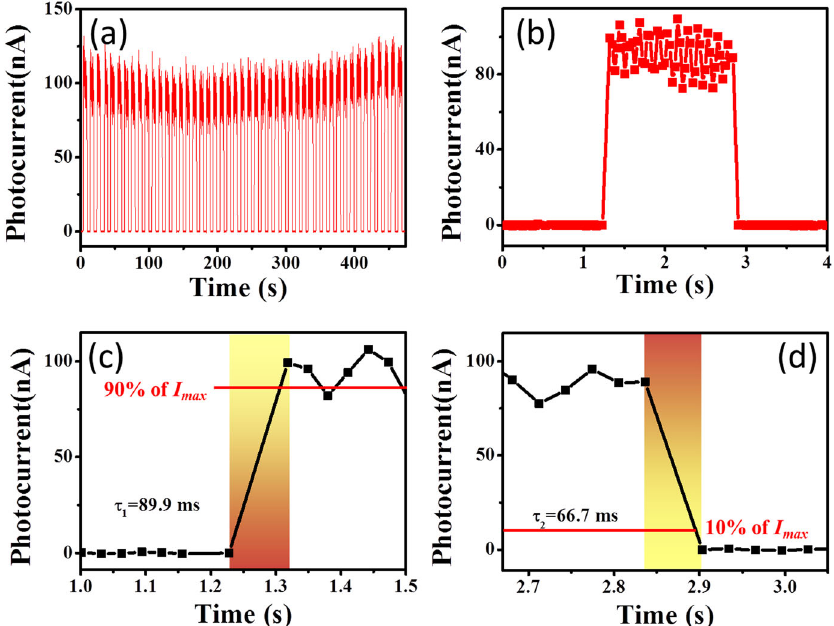
Fig. 4 a The reproducible on/off switching based on the PBDTT- ff Qx/PCBM BHJ photodetector under 365 nm light illumination at 10 V. b The photocurrent response is excited at 365 nm (300 mW/cm 2 ). The magni fi ed images of c rise time ( τ 1 ) and d decay time ( τ 2 ), in which the τ 1 is 89.9 ms and the τ 2 is 66.7 ms, respectively. I max is the maximum value of